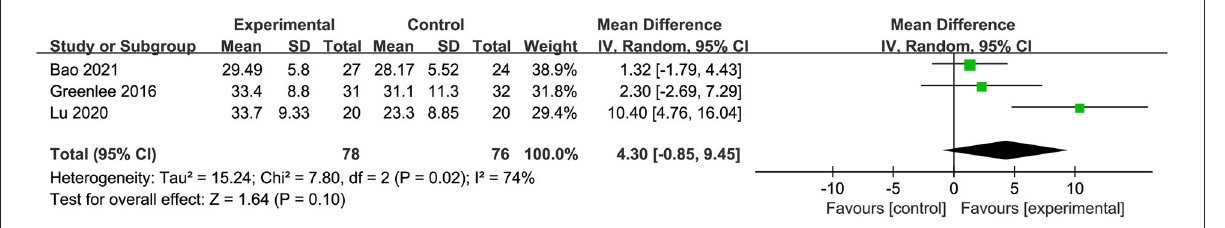
FIGURE4 Forest plot of comparison between acupuncture and placebo acupuncture on neurotoxicity and associated dysfunction.